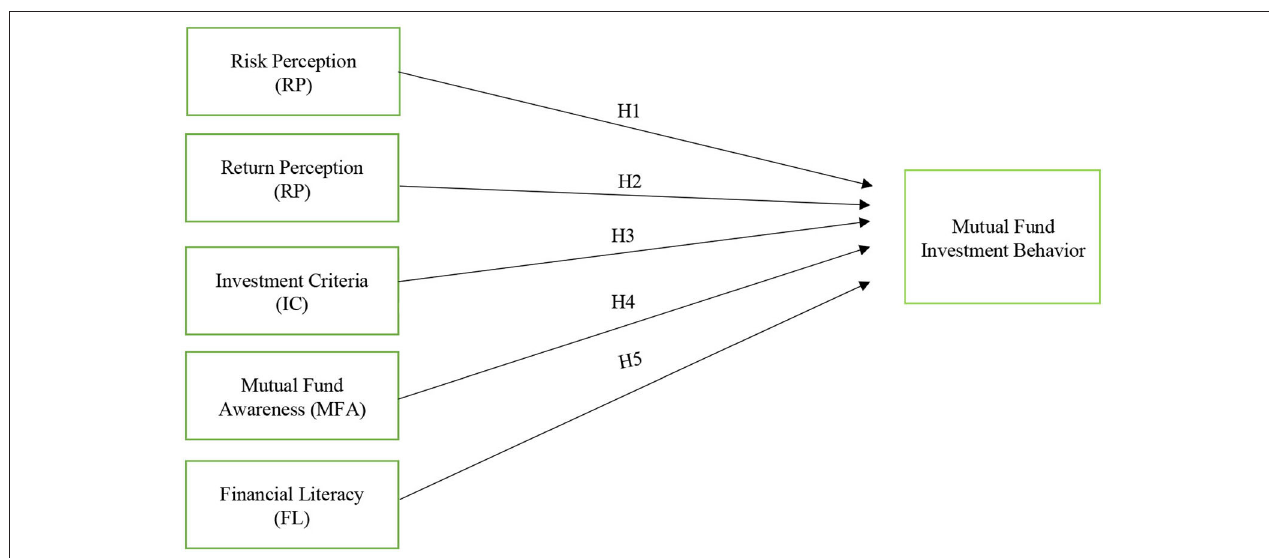
FIGURE 1 | Theoretical framework. The interpretation of Figure 1 is given in the section